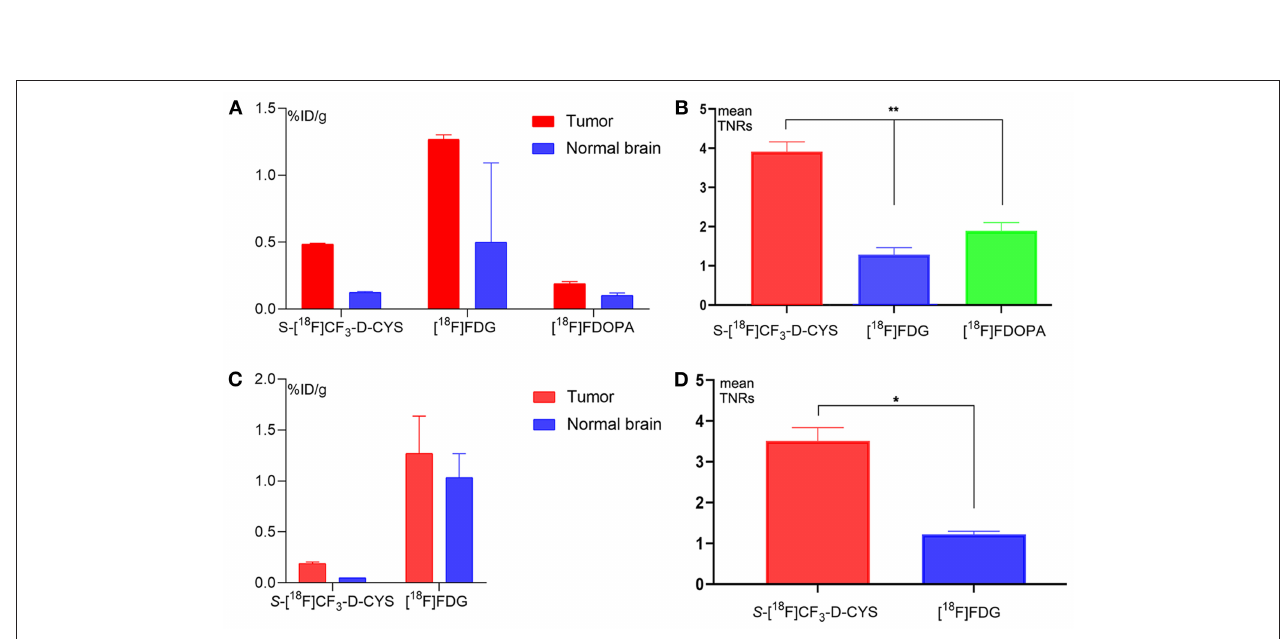
FIGURE 3 | (A,B) The uptake values of tumors and normal brains (A) , and the mean uptake ratios of the tumor to normal brain (B) for PET imaging with S- [ 18 F]CF 3 -D-CYS, [ 18 F]FDG, and [ 18 F]FDOPA for rats bearing orthotopic C6 glioma 3 weeks after xenografts (** P < 0.01). (C,D) The uptake values of tumors and normal brains (C) and the mean tumor and control brain uptake (D) for PET imaging with S- [ 18 F]CF 3 -D-CYS and [ 18 F]FDG for rats bearing orthotopic C6 glioma 1 week after xenografts. The mean TNRs for S- [ 18 F]CF 3 -D-CYS PET images (3.51 ± 0.33) were nearly three times higher than those for [ 18 F]FDG PET images (1.22 ± 0.08) (* P < 0.05).